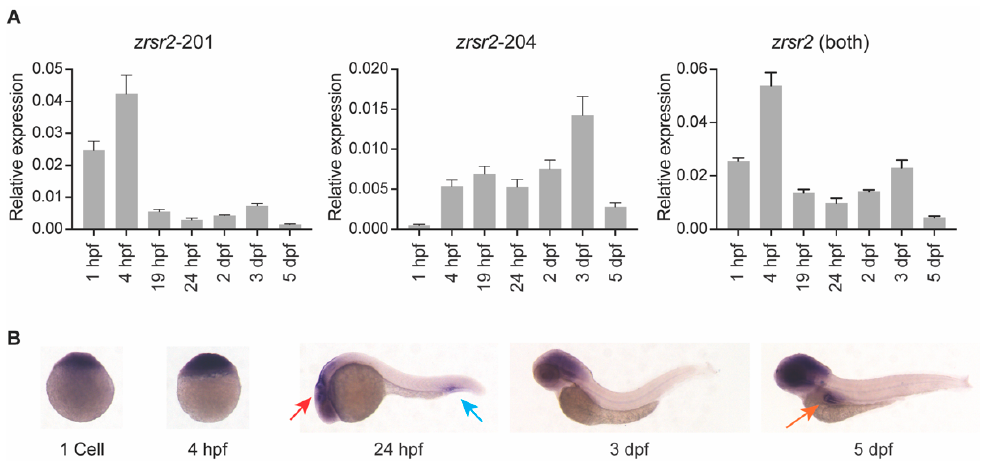
Figure 2. zrsr2 expression during zebrafish embryonic development. ( A ) qRT-PCR data showing expression of zrsr2 isoforms using primers unique to each isoform, and total expression using primers common to both isoforms in WT embryos from a series of stages during development as marked across the bottom of each plot. ( B ) WISH with zrsr2 antisense probe, showing its sites of expression in WT embryos at 1 cell, 4 hpf, 24 hpf, 3 dpf, and 5 dpf as marked. Specific zrsr2 expression is seen in the developing brain (red arrow) and the peripheral blood island (blue arrow) at 24 hpf, and in the intestinal bulb (orange arrow) at 5 dpf.